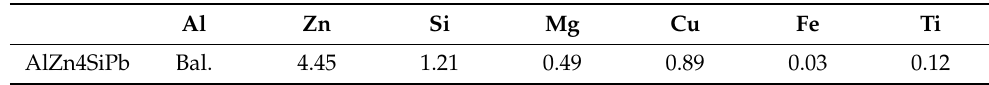
Table 1. Chemical constitutions of AlZn4SiPb sheet (wt.%).